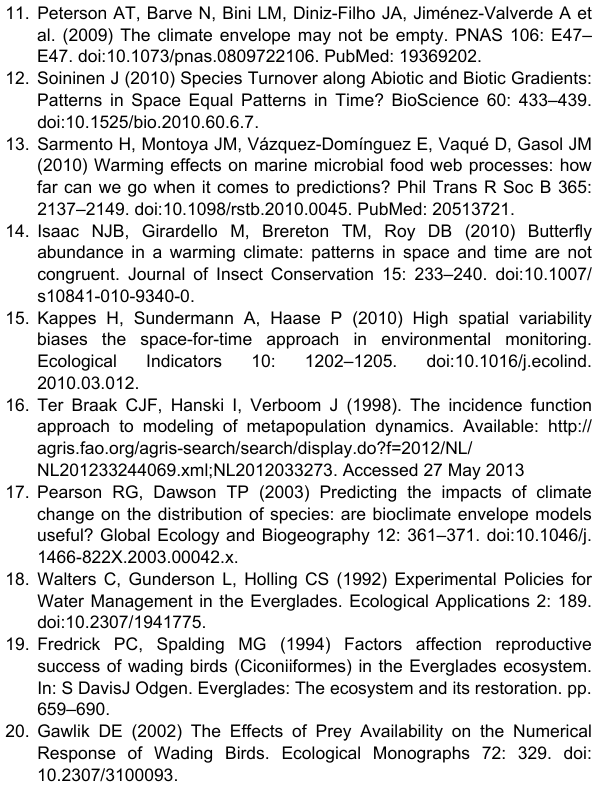
Figure S2. Heat map of non-contiguous year model fits. A) “Heat map” representation of fit for models created from a) non-contiguous years from the Mod Waters Data and b) The models from (a) fit to all combinations of groups of three contiguous years and spatial scales. (TIFF) Figure S3. Mean r 2 values of non-contiguous year models when predicting different spatial scales. Values are averaged across all groups of years that were predicted. Error bars are present, but are so small they are not visible. (TIFF) Figure S4. Mean r 2 values when models from CERP data predict Mod Waters data. The models were fit to groups of three contiguous years of Mod Waters data at different spatial scale. (TIFF) Table S1. Bias of contiguous models when predicting different spatial scales. Bins were created to examine bias at varying days since dry (0-250, 251-500, 501-750, and >1000). Numbers represent the number of bins that had a bias value > 5. In all cases where there were spikes in bias values, these occurred in bins that had the largest DSD. (TIFF)